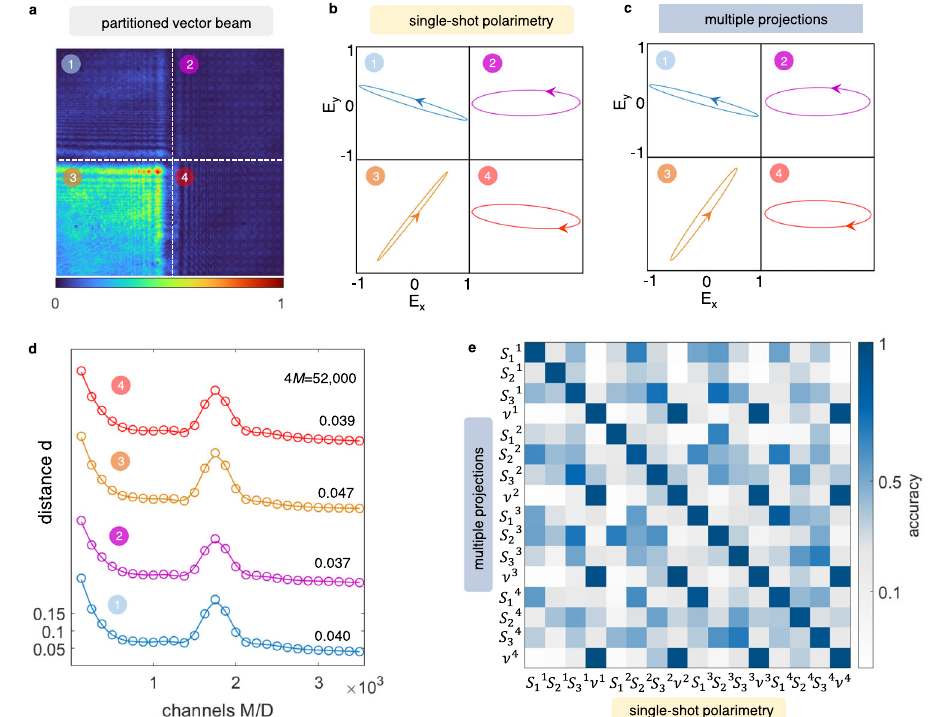
Fig. 4 | Single-shot polarimetry of four-parted vector beams. a A generated beam with D =4. We show the spatially-resolved vertical intensity component p V . b Polarization ellipses observed in a single shot ( M / D =1000) and c via multiple projective measurements. d Distance of the j -th mode as a function of the